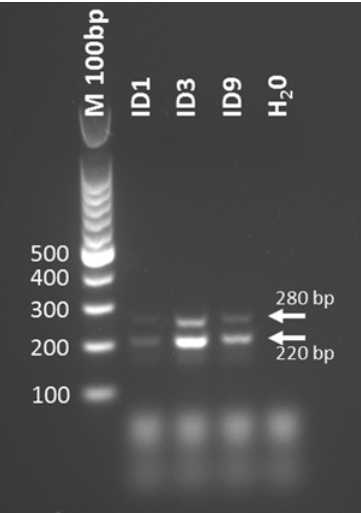
Figure 3. Polymerase chain reaction (PCR)-based marker for dis- tinguishing Stagonosporopsis cucurbitacearum . Lane M is a 100-bp ladder with sizes of visible fragments indicated. Three fungal iso- lates (ID1, ID3 and ID9) from butternut squash fruit were analyzed with PCR-based markers using three sets of primers (Db01, Db06 and Db06) in a single reaction. Two amplicons of 220 and 280 bp were produced and no fragment of 360 bp was visible, despite the presence of the microsatellite locus Db01.